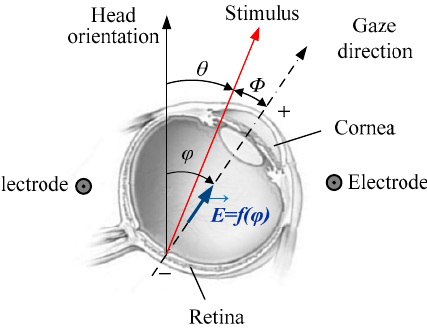
Figure 2. Eyeball modelled as a dipole and angular deviation of the eye movements in response to a → E = f ( ϕ ) represents the electric field dependent on the eye rotation stimulus. The vector